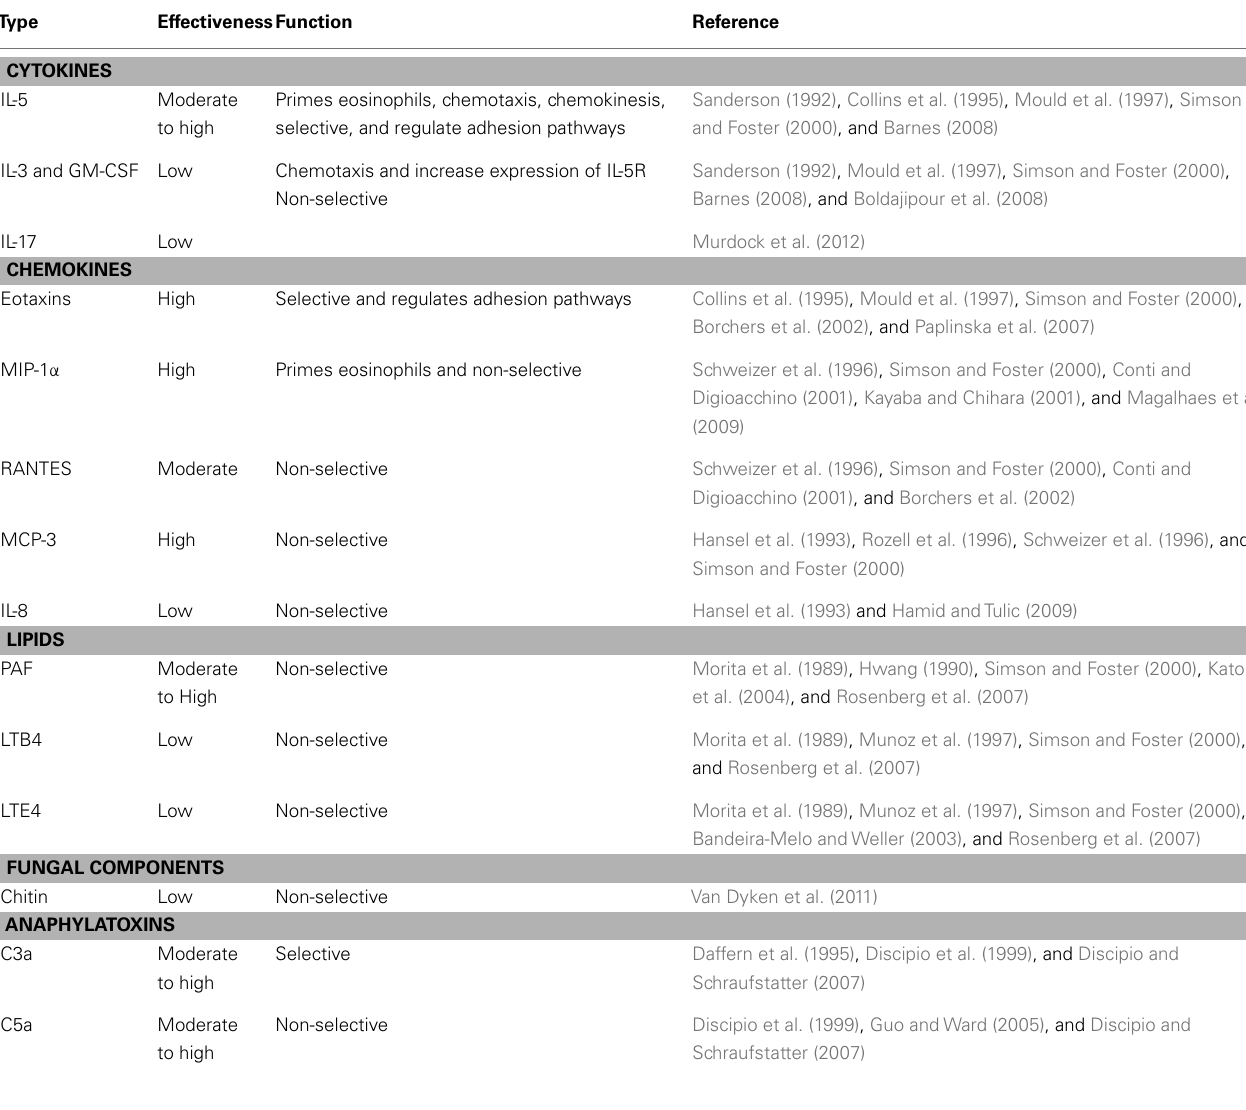
Table 1 | Mediators involved in eosinophil